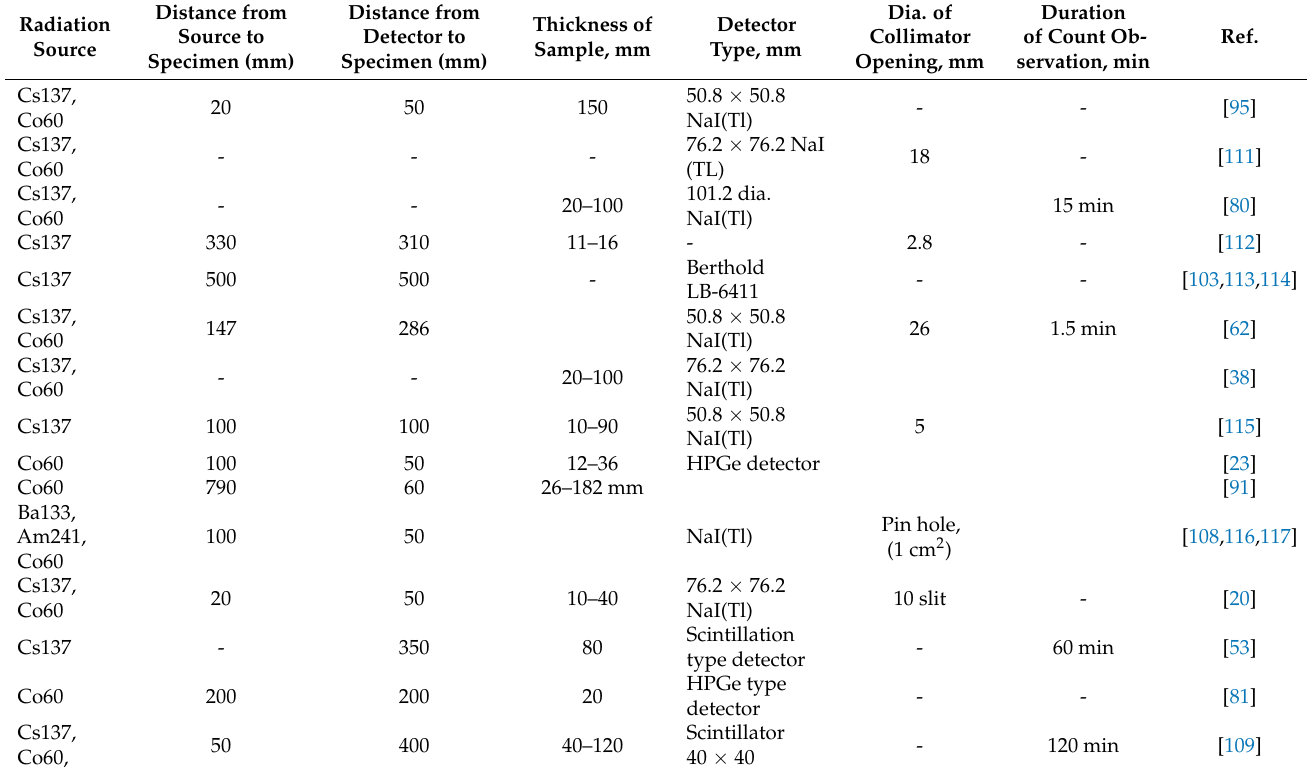
Table 2. Summary of radiation test